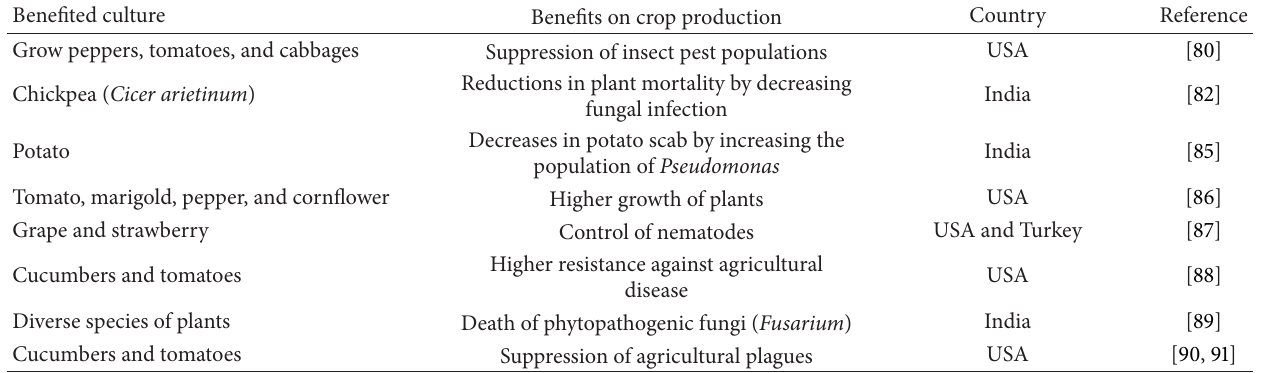
Table 3: Uses of vermicompost for